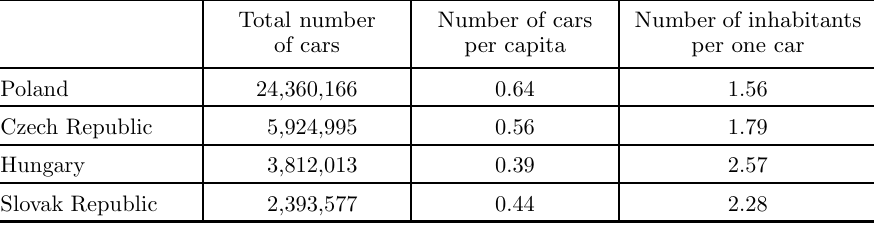
Total number of passenger cars in the V4 countries Total number Number of cars Number of inhabitants of cars per capita per one car 24,360,166 0.64